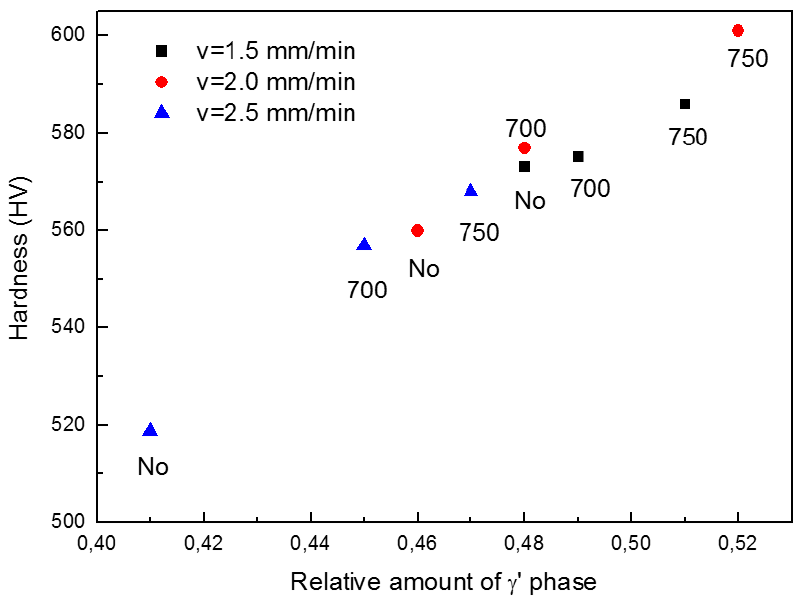
Figure 10. Hardness vs. relative amount of γ ’ phase in MZ of samples realized with pre-heating at 300 °C and different pass speeds. The effect of PWHT temperature is also displayed.